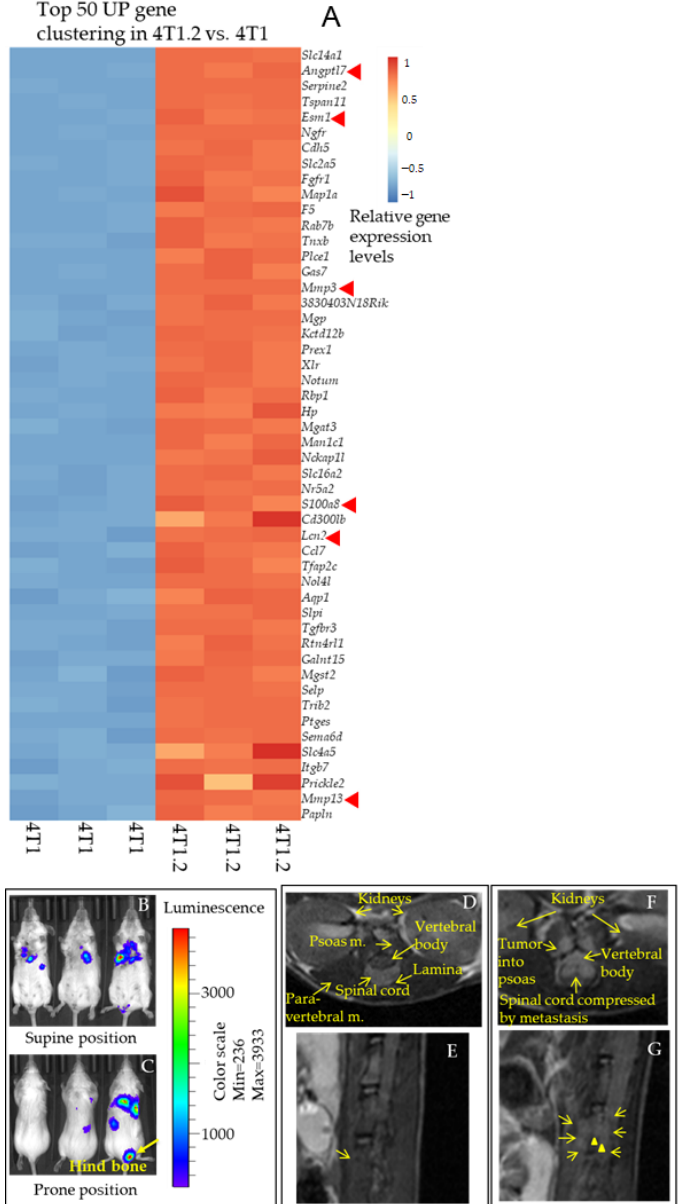
Figure 1. Proangiogenic and pro-inflammatory secretory protein-encoding genes are upregulated in metastatic variant 4T1.2 vs. parental 4T1 cells. ( A ) RNA-Seq heat map for 50 upregulated genes in 4T1.2 vs. 4T1 cells. Genes indicated in bold red arrow revealed a fold change (>6-fold vs. 4T1) is the mediator protein-encoding genes are elevated in the 4T1.2 cells. Of note, there are 3250 genes altered (upregulated and downregulated; padj < 0.05; fold change (FC) > 2) in these cell lines. In total, 1729 genes are upregulated in 4T1.2 cells, whereas 1521 genes are downregulated in 4T1.2 cells vs. 4T1 cells. (B-C) On day 17 of the inoculation of cancer cells in the implantation/resection model, IVIS live images of Balb/c mice bearing metastatic 4T1.2-Luc+ breast cancer cells at primary and metastatic sites, supine ( B ), and prone ( C ) positions are shown. Arrow indicates hind bone 4T1.2-Luc+ metastasis. Representative mice images are shown ( n = 5). ( D – G ), MRI of 4T1.2-Luc+ spine bone metastasis in vivo. On the day of sacrifice (day 17) of 4T1.2-Luc+ metastatic cancer-bearing Balb/c mice, an MRI scan was performed for the mice, and representative images were shown. Top left ( D ) and right ( F ), two representative T2-weighted transverse slice images of Balb/c mice with 4T1.2-Luc+ metastatic cancer. Spine metastasis is not visible in Figure D, whereas in Figure 1F, tumor cells infiltrate into the psoas, tumor extended into the spinal canal, clinically it is called “Metastatic Epidural Spinal Cord Compression (MESCC)”. Bottom left ( E ) and right ( G ), two representative spine images visualized by the T2-weighted MRI, sagittal projection. Arrows indicate spine bone metastasis ( G ). Data are representative of n = 5